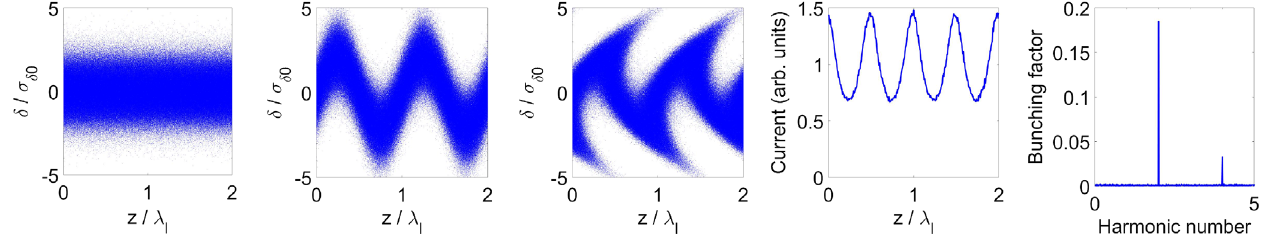
FIG. 5. The longitudinal phase-space evolution, final current distribution and bunching factor when α ð δ Þ ¼ α 1 δ is used for microbunching in CHG or HGHG, as modeled by Eq.